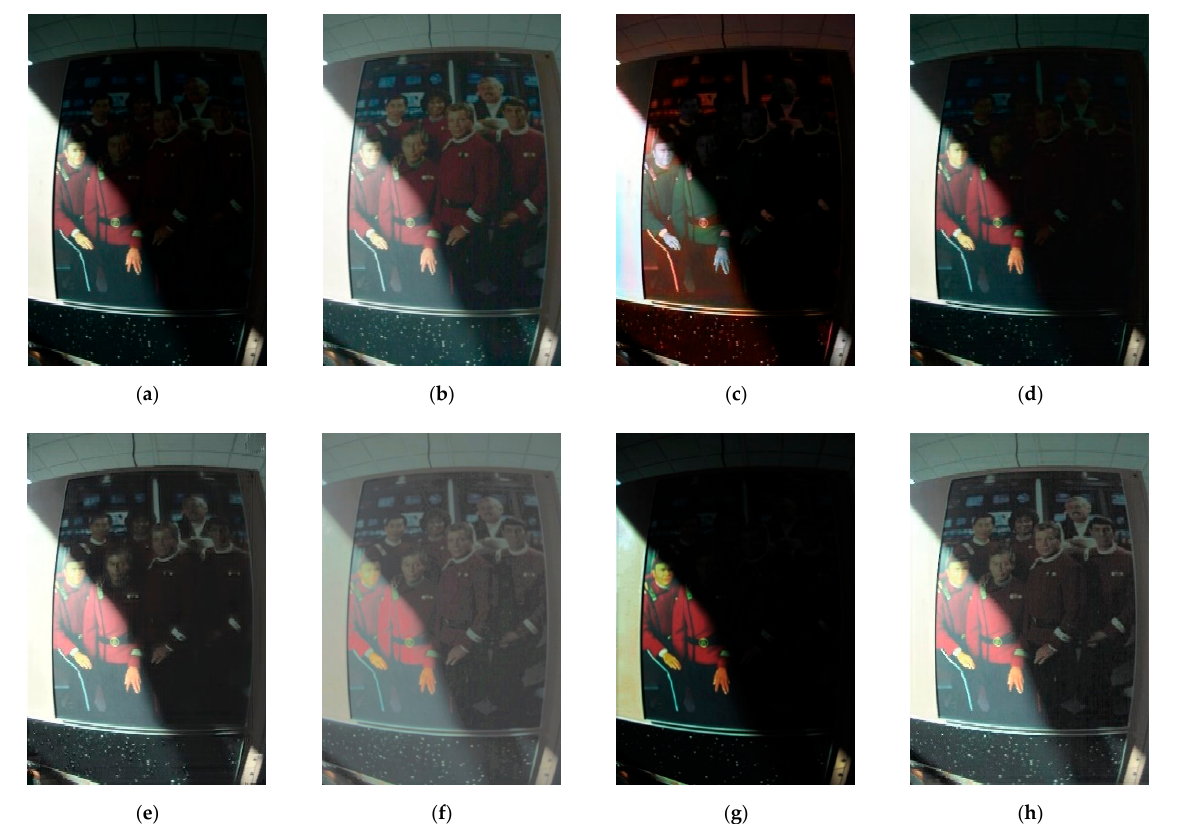
Figure 11. High-contrast image #1: ( a ) input, ( b ) target, ( c ) CycleGAN, ( d ) Lum CycleGAN, ( e ) EV GAN, ( f ) HDRCNN, ( g ) ExpandNet, and ( h ) the proposed model.